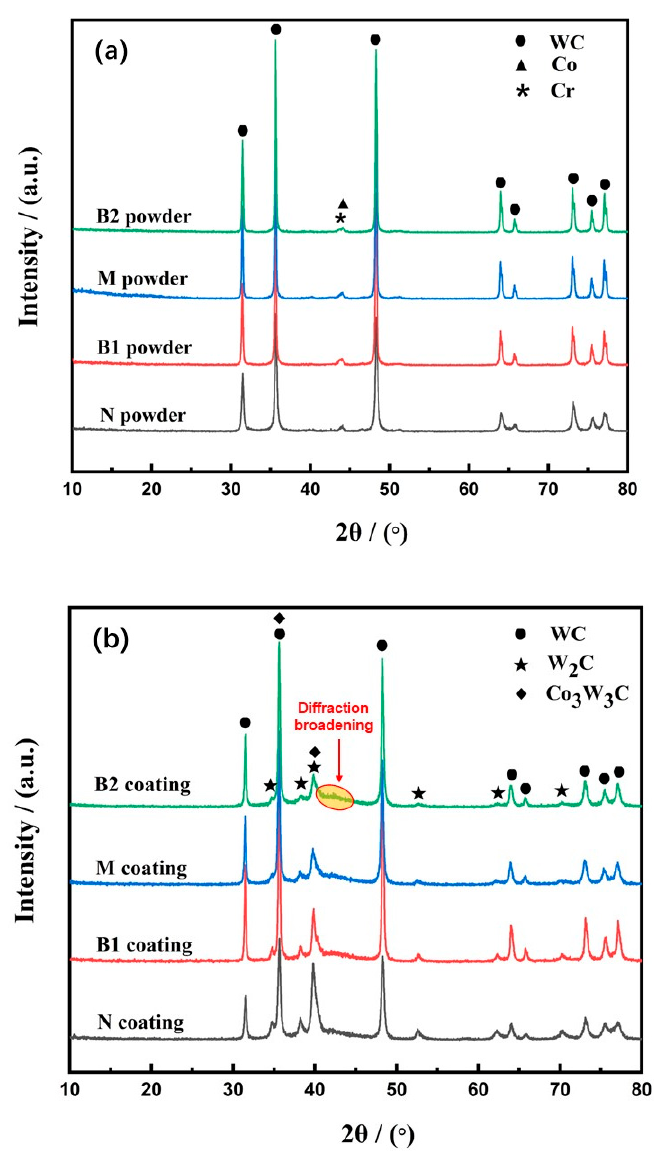
Figure 3. XRD patterns of the WC–10Co–4Cr feedstock powders ( a ) and the coatings ( b ).